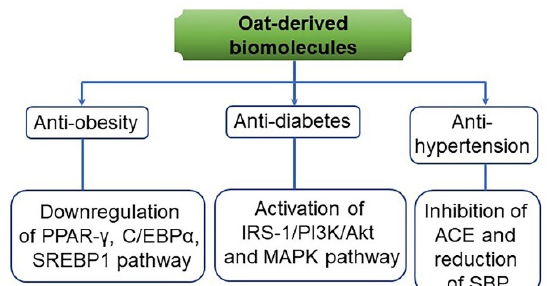
Figure 13. A predicted action mode of anti-obesity, anti-diabetes, and anti-hypertension effects from oat-derived biomolecules and by-products. Anti-obesity is associated with the downregulation of peroxisome proliferator-activated receptor gamma (PPAR- γ ), CCAAT-enhancer-binding protein isoform alpha (C/EBP α ), and sterol regulatory element-binding protein 1 (SREBP1). Anti-diabetes is involved in the activation of insulin receptor substrate 1 (IRS-1)/phosphoinositide 3-kinase (PI3K)/protein kinase B (Akt) and AMP-activated protein kinase (AMPK) signaling pathway. Anti-hypertension is related to the inhibition of angiotensin-converting enzyme (ACE) and the reduction of systolic blood pressure (SBP) [147].